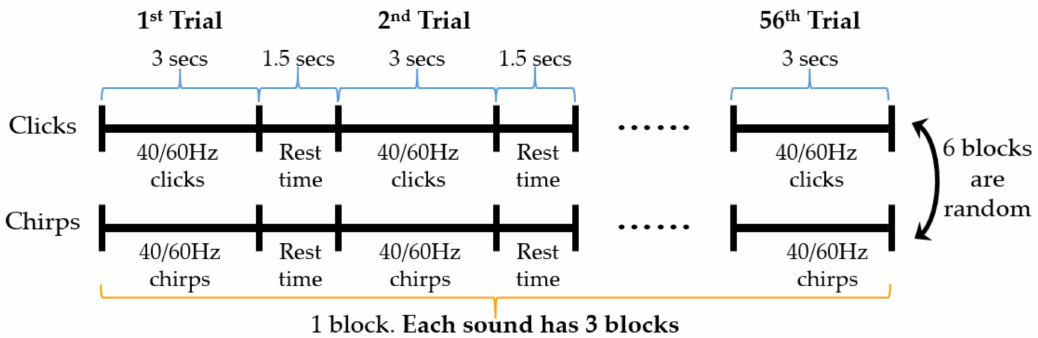
Figure 2. The flow chart of auditory evoked paradigm in this study: each frequency is represented 28 times in each